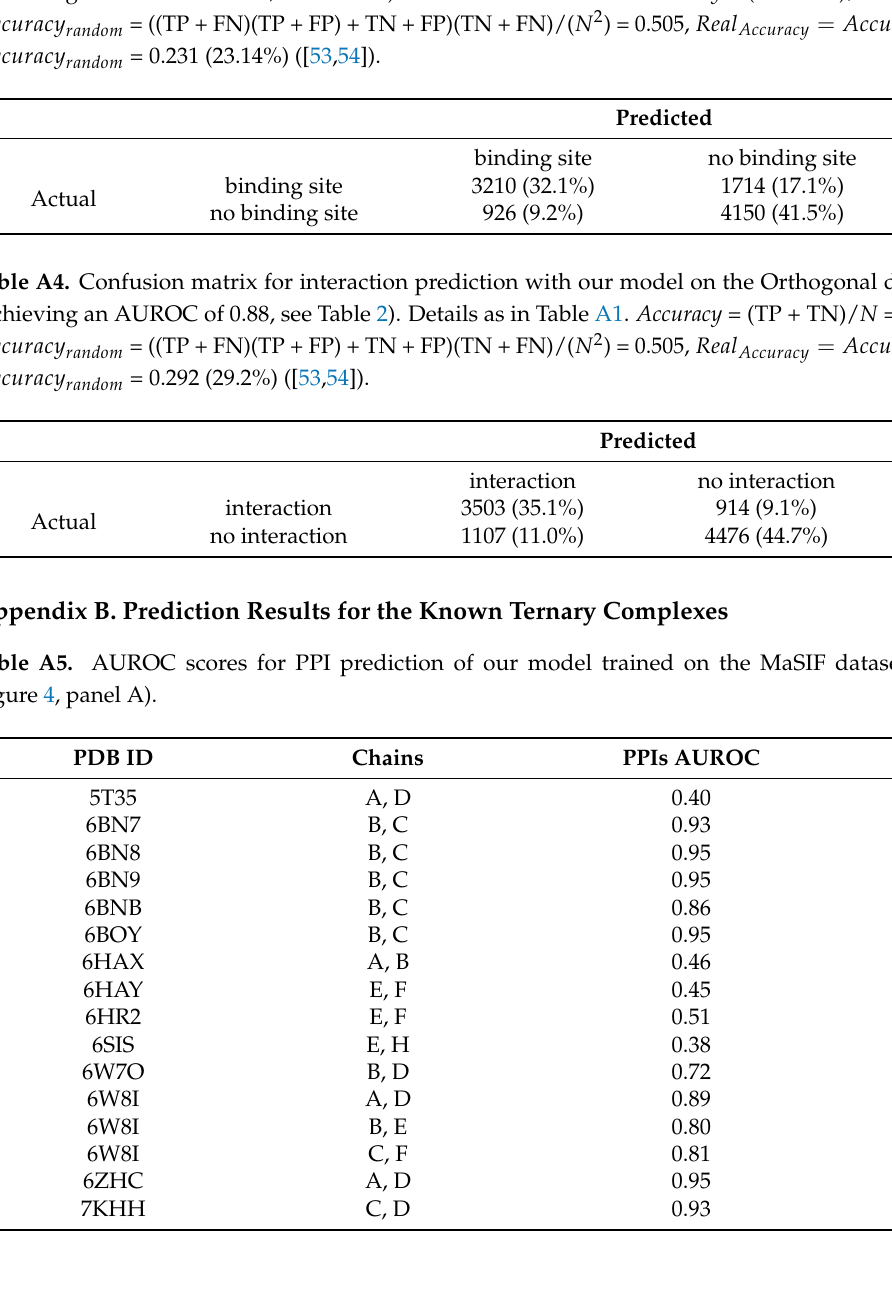
Table A3. Confusion matrix for interaction prediction with our model on the Orthogonal dataset (achieving an AUROC of 0.79, see Table 2). Details as in Table A1. Accuracy = (TP + TN)/ N = 0.736,